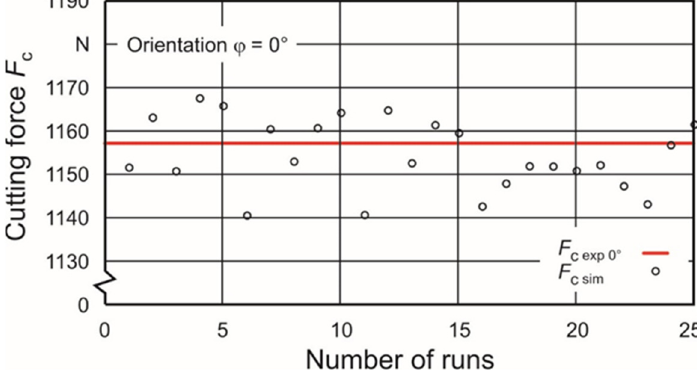
Figure 6. Second iteration with 25 runs for orientation φ = 0°.